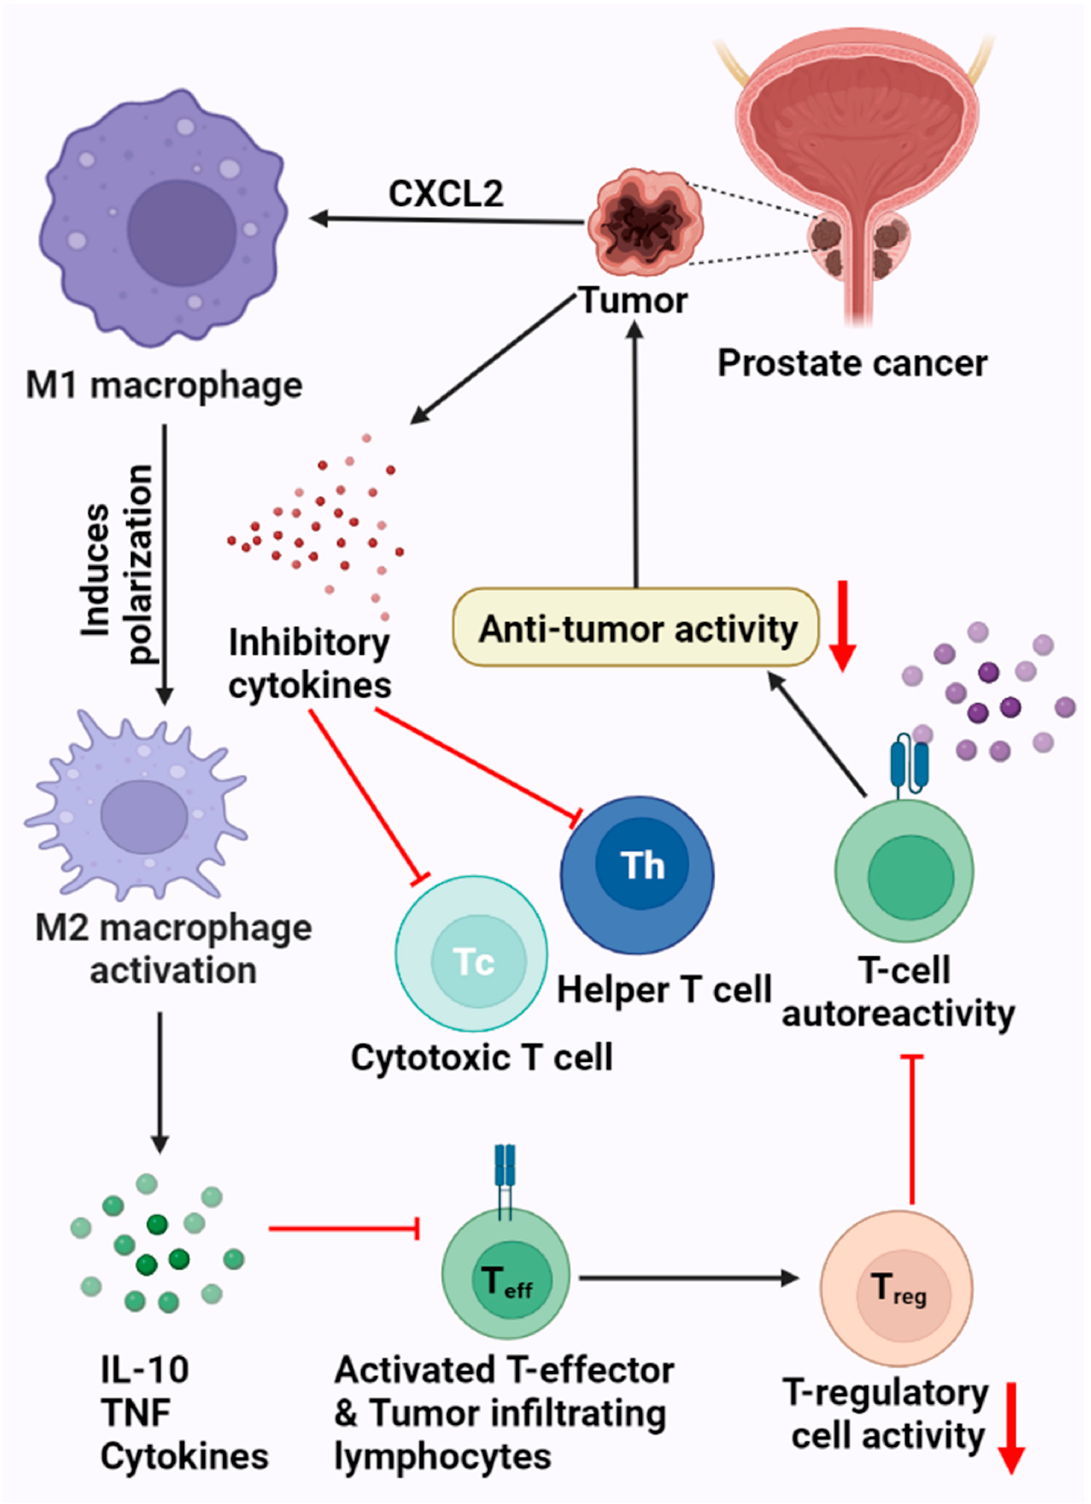
Figure 1. Prostate tumor microenvironment. This figure displays the various mechanistic processes by which PCa can shield or evade the body’s immune system. This includes the production of inhibitory cytokines, resulting in the downregulation of the T H and Tc cells. Prostate cancer cells can also activate the M2 macrophages, leading to the production of IL-10, TNF, and various cytokines, which in turn inhibits the T